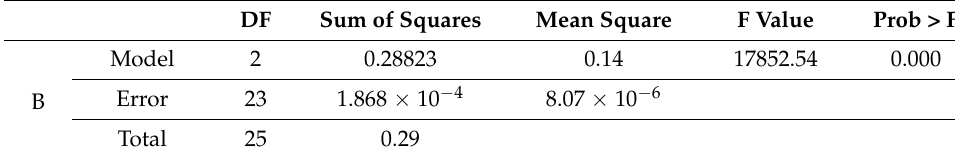
Table 4. ANOVA analysis of extension vs. resistance of SS conductive